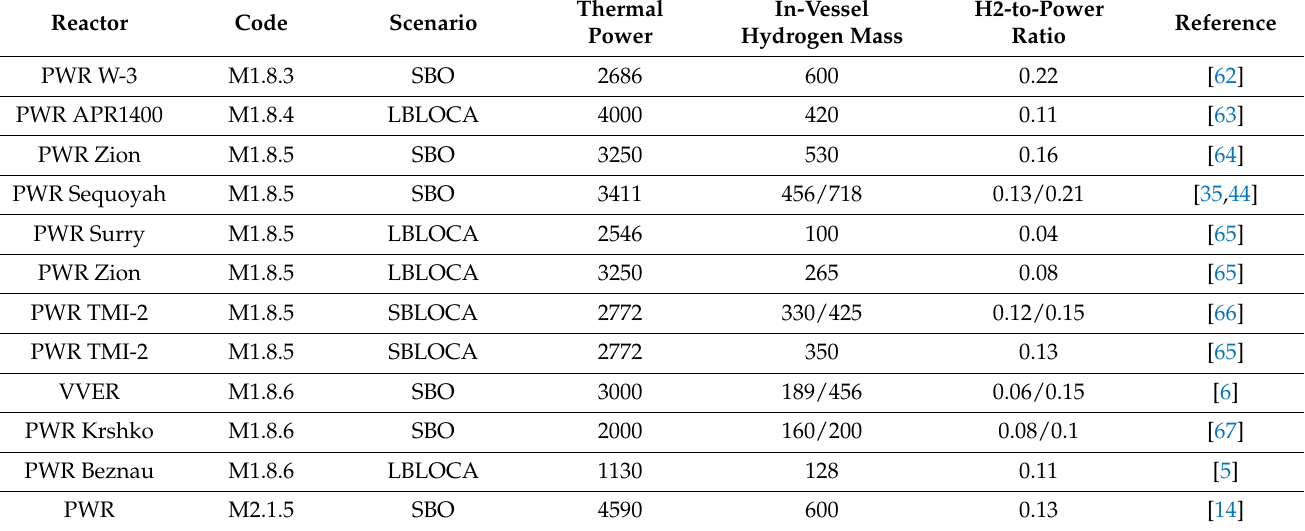
Table 5. Comparison of different MELCOR literature results for in-vessel H 2